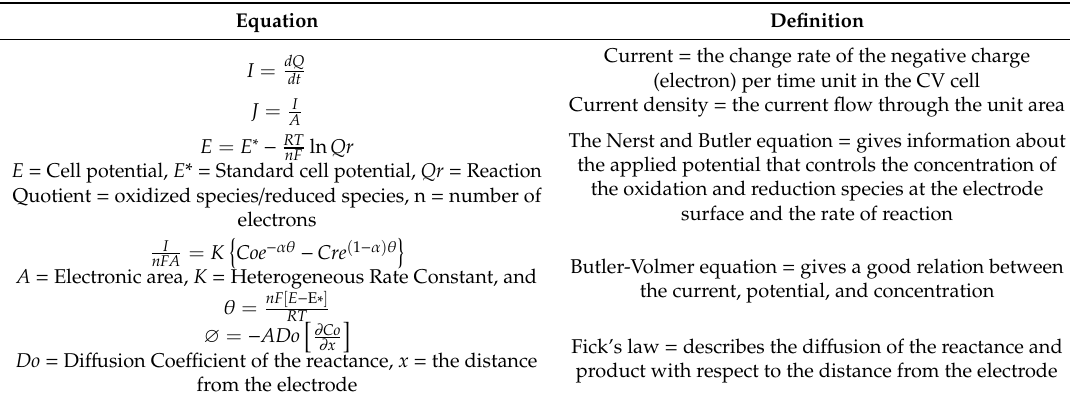
Table 2. Basic equations of the CV